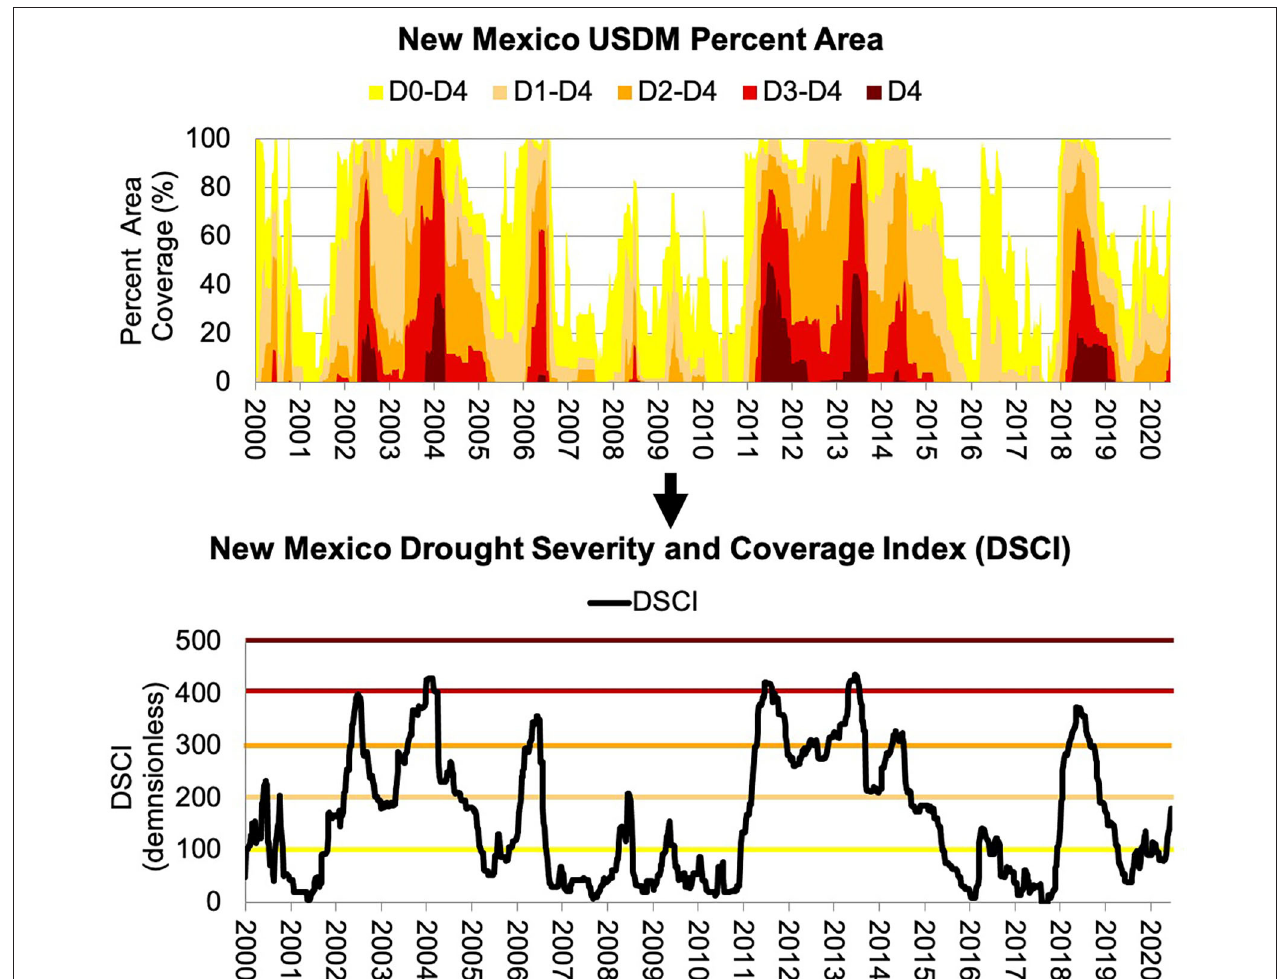
FIGURE 4 | Weekly time series that show how the USDM categorical plot is transformed into the continuous DSCI. The continuous DSCI ( USDM ) values are 0–99 ( None ), 100–199 ( D0 ), 200–299 ( D1 ), 300–399 ( D2 ), 400–499 ( D3 ), and 500 ( D4